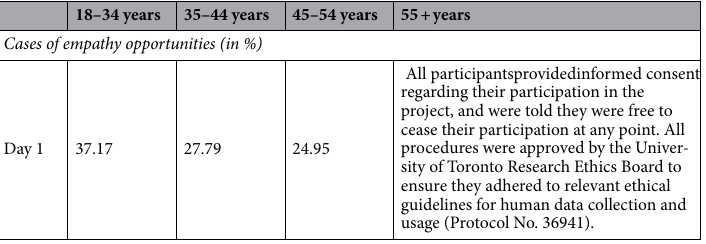
Table 4. Proportion of how often participants reported an empathy opportunity, an opportunity to be the target of empathy, and acting prosocially, as well as the mean value of well-being relative to all surveys answered per day, shown as a function of survey day and age